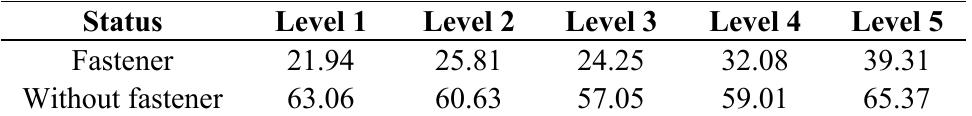
Table 6. Matching distance for Figure 14.